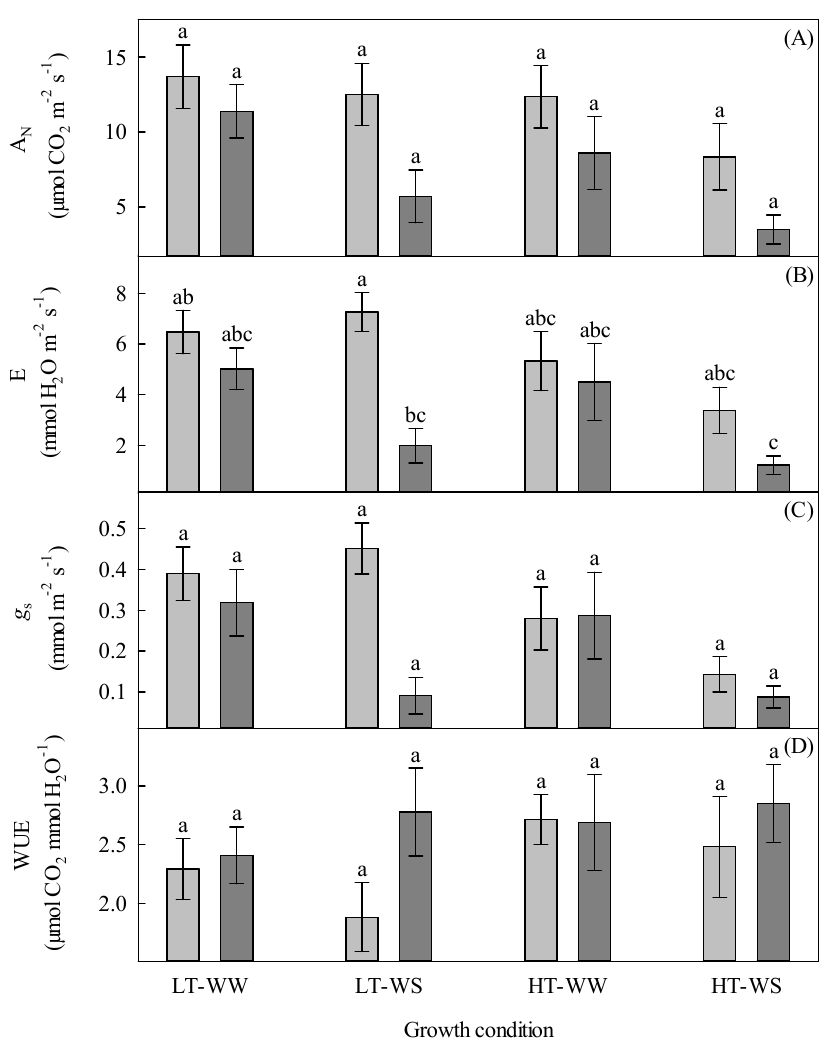
Figure 4. Gas exchange of 33-day-old tomato plants grown under eight experimental conditions including two temperature regimes, two watering regimes, and two abscisic acid concentration applications after 12 days of initial germination and growth in growth chambers with lower temperature, watering to field capacity, and without abscisic acid application. ( A ) Net CO 2 assimilation (AN), ( B ) transpiration (E), ( C ) stomatal conductance (gs), and ( D ) water use efficiency (WUE). LT, lower temperature; HT, higher temperature; WW, well-watered; WS, water stressed; light gray, no abscisic acid; dark gray, abscisic acid. Data are the means ± SE of 88 samples from three experiments. Bars with different letters above them are significantly different according to Scheffé’s multiple comparison procedure at the 5% confidence level.